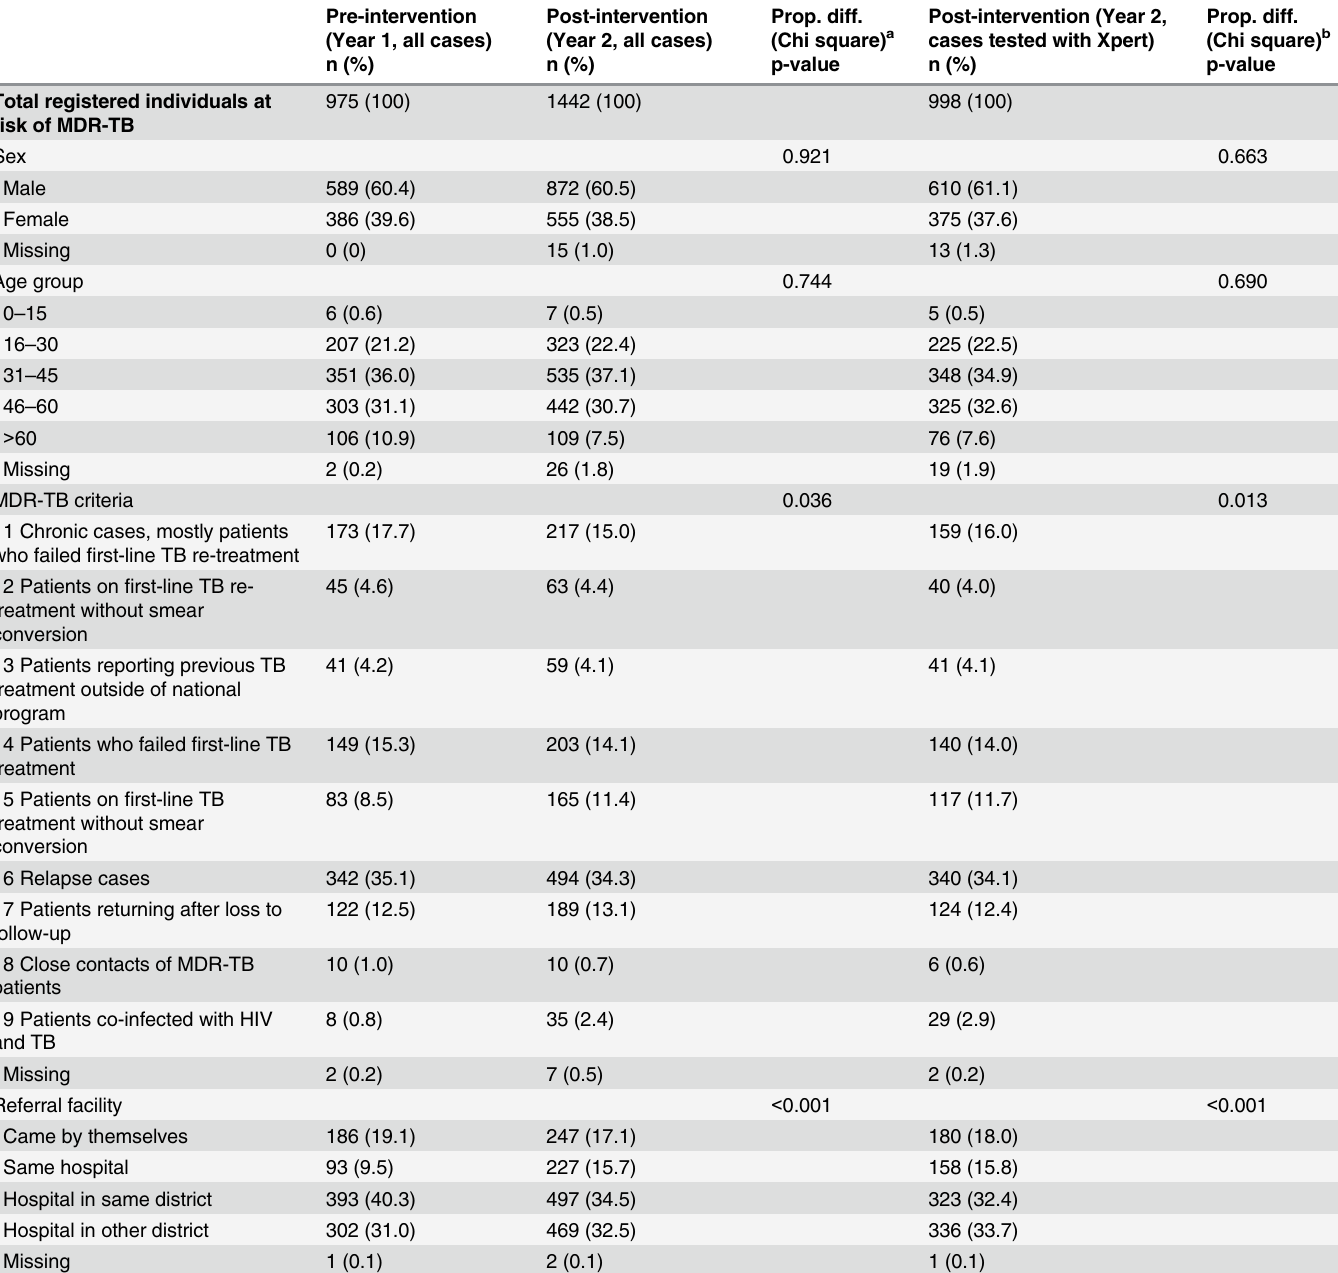
Table 2. Characteristics of individuals at risk of multidrug-resistant pulmonary TB registered from March 2011 to February 2012 (Year 1) and March 2012 to February 2013 (Year 2) at three provincial hospitals in Java,